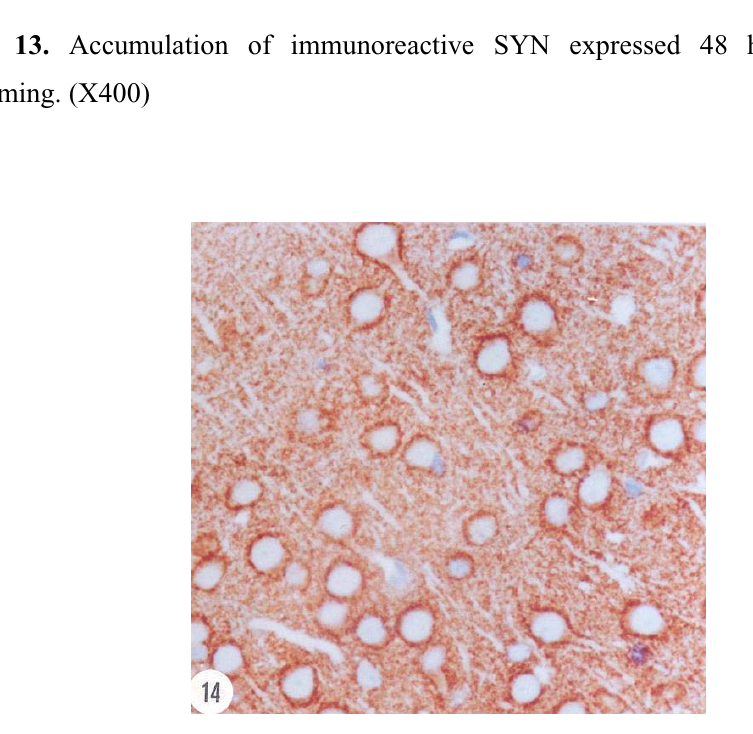
Figure 14. Decreased SYN immunoreactivity at the periphery of cytons 72 hr after high dose envenoming.